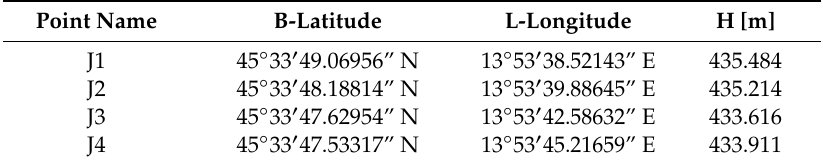
Table 3. Static positions of the jammers and times of the 3-minute jammings.